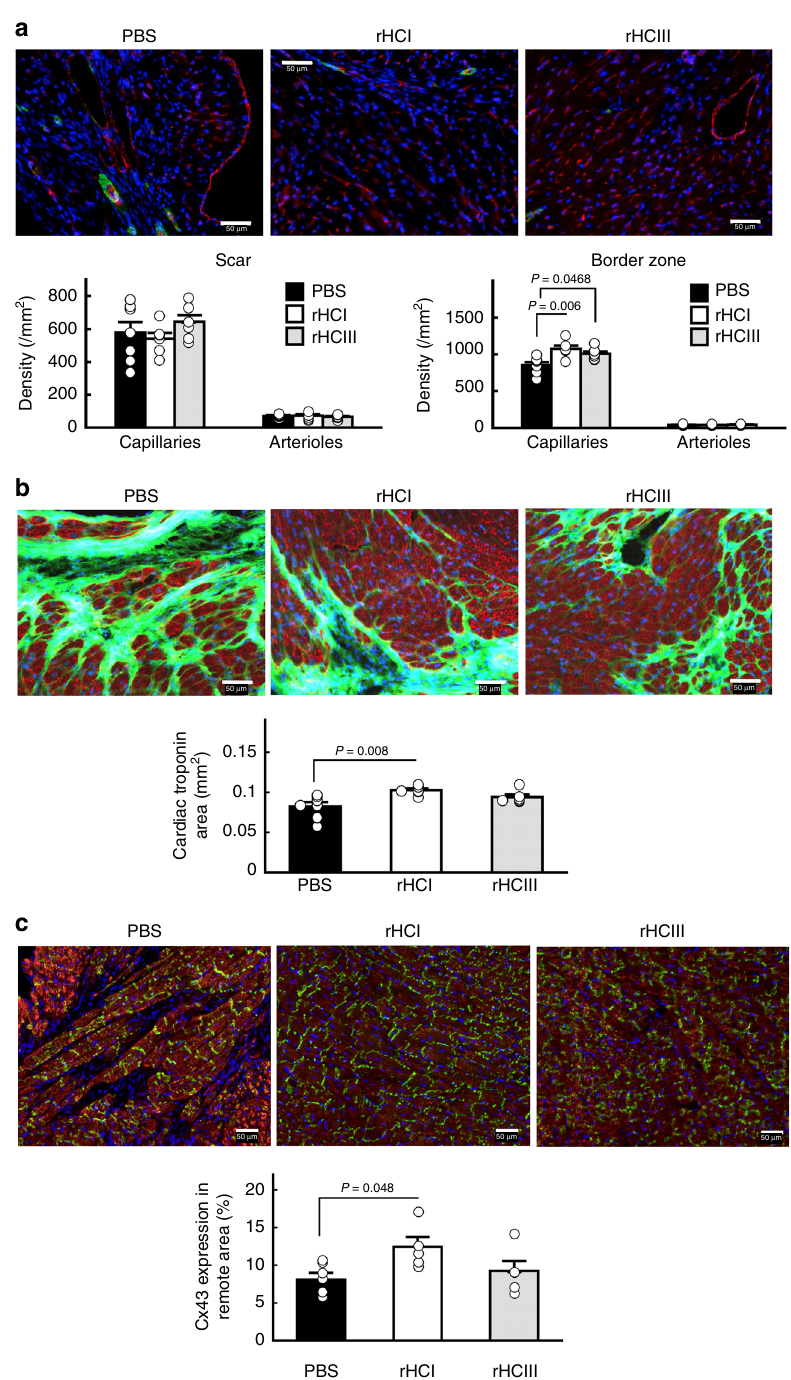
Fig. 4 rHC matrix increases vascularity and preserves cardiomyocytes post-MI. a Immunohistochemistry analysis and quanti fi cation (number/mm 2 ) of capillary and arteriole number in the myocardial scar and border zone after treatment with PBS, rHCI, or rHCIII. CD31, red; α -SMA, green; DAPI, blue ( n = 6 – 7). b Immunohistochemistry analysis and quanti fi cation of total area (in mm 2 ) positive for cardiac troponin I (cTnI) staining in the border zone after treatment with PBS, rHCI, or rHCIII. cTnI, red; wheat germ agglutinin, green; DAPI, blue. c Immunohistochemistry analysis and quanti fi cation of connexin 43 (Cx43) expression (percent area) in the remote area after treatment with PBS, rHCI, or rHCIII. Cx43, green; cTnI, red; DAPI, blue ( n = 6 – 7). P- values were determined by one-way ANOVA using Holm ’ s multiple comparison. The data are presented as the mean ± SEM. Source data are provided as a Source Data fi le. For a – c , n indicates the number of mice per